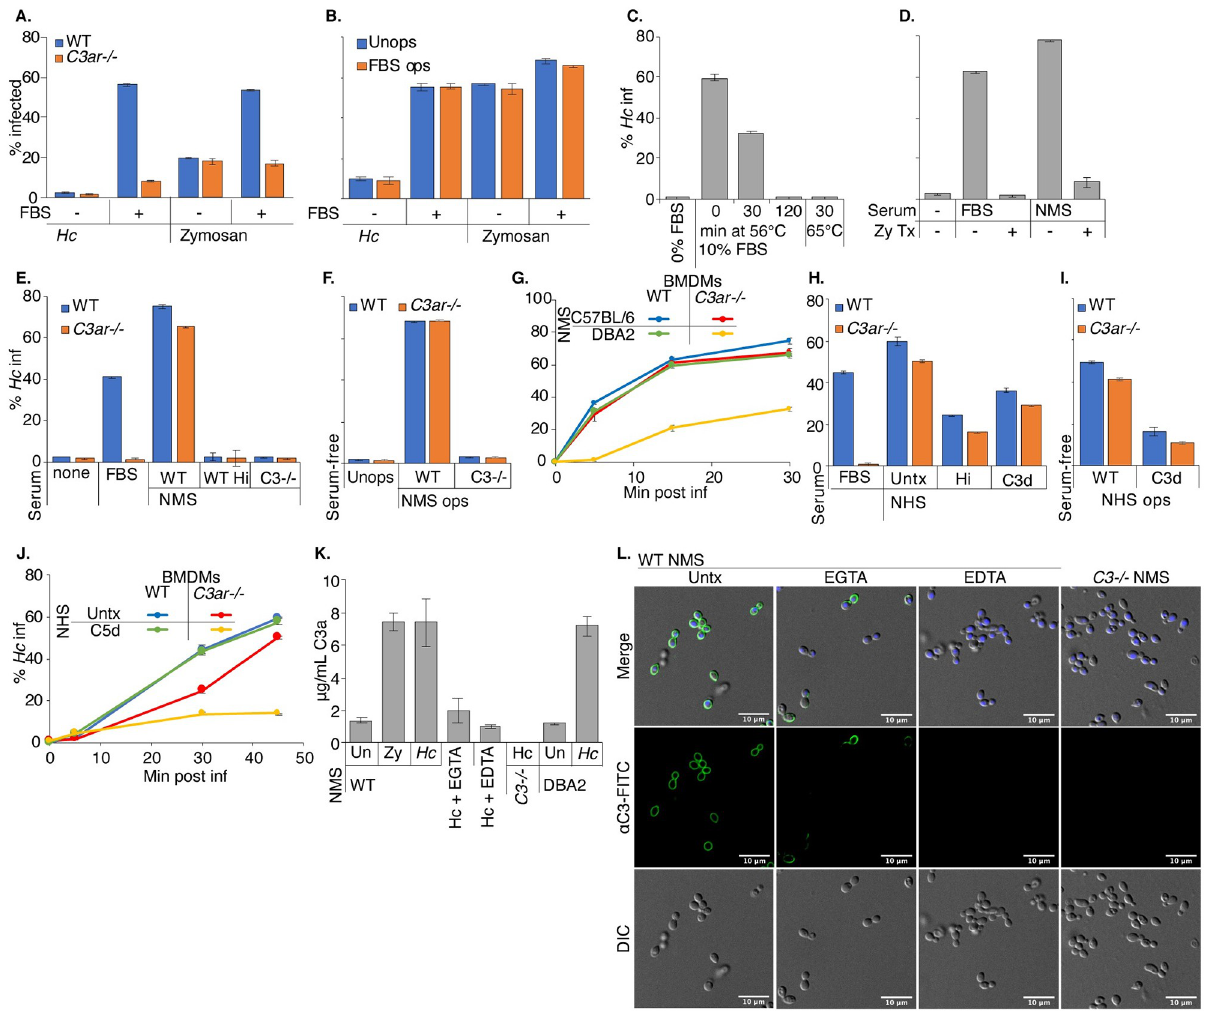
Fig 4. Serum C3 promotes complement opsonization, C3a release, and macrophage phagocytosis of Hc yeast. A. FBS stimulates macrophage phagocytosis of fungi in a C3aR-dependent manner. BMDMs were infected with mCherry-expressing Hc or FITC-labelled zymosan (30 min, MOI5) in the presence or absence of 20% heat-treated FBS (FBS). Phagocytosis was assessed via flow cytometry (n = 3 biological replicates). B. FBS does not promote macrophage phagocytosis of Hc via opsonization. Hc and zymosan particles were pre-incubated with 10% heat-treated FBS for 30 min at 37˚C, washed, and used to infect BMDMs (2h, MOI2). Phagocytosis was measured using flow cytometry (n = 2 biological replicates). C-D. Prolonged or intense heat-treatment and zymosan treatment eliminates the phagocytosis-stimulating properties of serum. C. Macrophage phagocytosis of Hc (MOI5, 45 min, n = 3 biological replicates) was assessed in media supplemented with 10% FBS that had been subjected to heat treatment (C) at 56˚C for up to 2h, at 65˚C for 30 min, or that had been pre-treated with zymosan (D) (1X10 8 particles/mL, 60 min at 37˚C). Phagocytosis was measured by